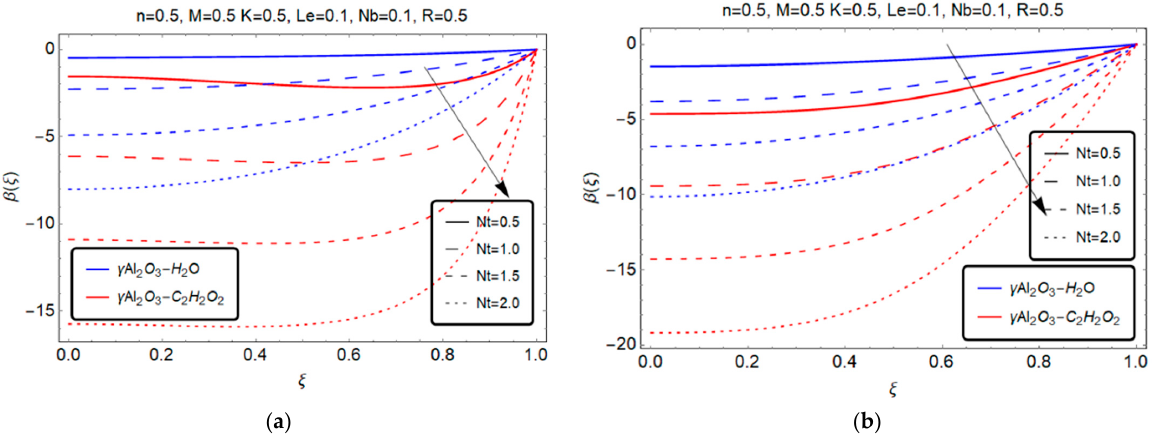
Figure 12. Effect of Thermophoresis parameter 𝑁 (cid:3047) on 𝛽(𝜉) . ( a ) S > 0; ( b ) S < 0.